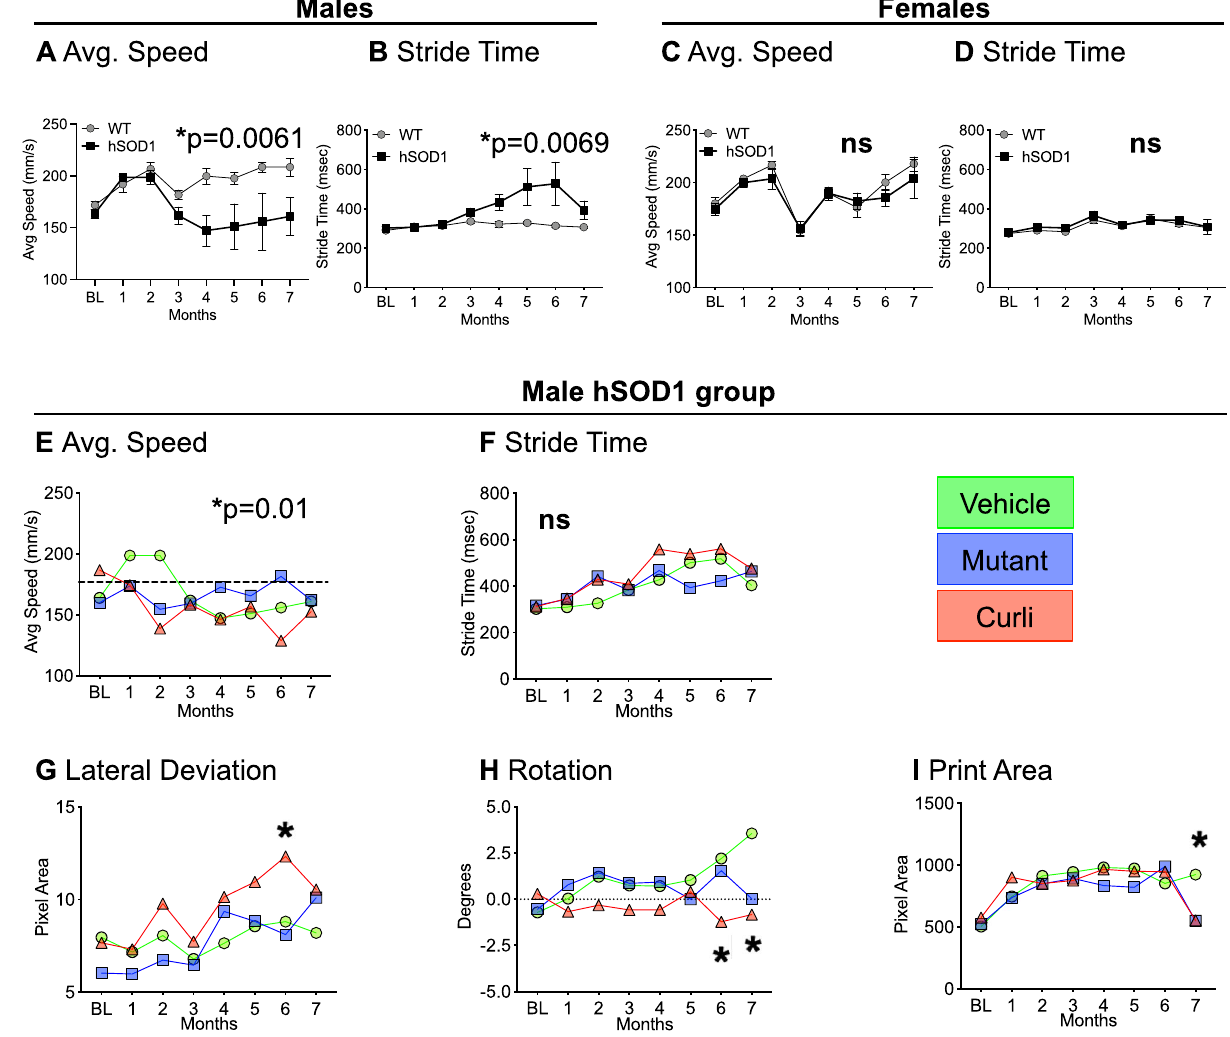
Figure 3. Gait kinematics and locomotion characteristics. ( A – D ) Average running speed and stride time measured with TreadScan analyses showed significant slowing of pace in hSOD1 males compared to WT controls ( A ). This finding was absent in females ( C ). Stride time, defined as the time elapsed between two successive initiations of stances, showed significant increases in hSOD1 males compared to WT controls ( B ). This finding was absent in females ( D ). Data represented as mean + /-SEM for ( A – D ). ( E ) Within the male hSOD1 cohort, the ANOVA was significant for effect of time on running speed, but bacterial feeding did not have a significant effect. ( F ) Bacterial feeding also did not significantly effect stride time. Within the male hSOD1 group , curli-fed mice showed significant differences for maximum lateral deviation of hind feet from the axis of the body ( G ), inability to efficiently move body from a straight axis ( H ), and a smaller print area of the hind feet ( I ) towards later months. * p < 0.05, Repeated measures two-way ANOVA or mixed-effects model analyses (REML) with Tukey’s multiple comparisons. n = 6–8 per Overall, curli-fed hSOD1 males showed significant maximum lateral deviation of hind feet and variations in rotation compared to vehicle and mutant-fed hSOD1 males measured with TreadScan analyses. These measures of locomotion have not been associated previously with the ALS phenotype in mice. Chronic gut exposure to mutant and curli‑producing E. coli enhanced markers of skeletal mus‑ cle atrophy. We examined tibialis anterior for histochemical staining and gastrocnemius for mRNA and protein expression for several markers of muscle atrophy. We performed immunohistochemistry in the tibialis anterior muscle utilizing an antibody specific for hSOD1-G93A protein (MS785, GTX57211). Within the male hSOD1 cohort, both mutant and curli-fed mice showed increased hSOD1-positive staining compared to vehicle (Fig. 4A,B). Increased hSOD1-G93A staining may indicate increased SOD1-positive aggregations, but we did not specifically test for aggregations. In gastrocnemius, Beclin and p62, markers of autophagy, were significantly increased in both mutant and curli-fed groups not only in hSOD1 males (Fig. 4C) but in all cohorts—male WT, female WT and female hSOD1 (Supp. Fig. 4A–C). TNFα, a well-known muscle cachectin, was significantly